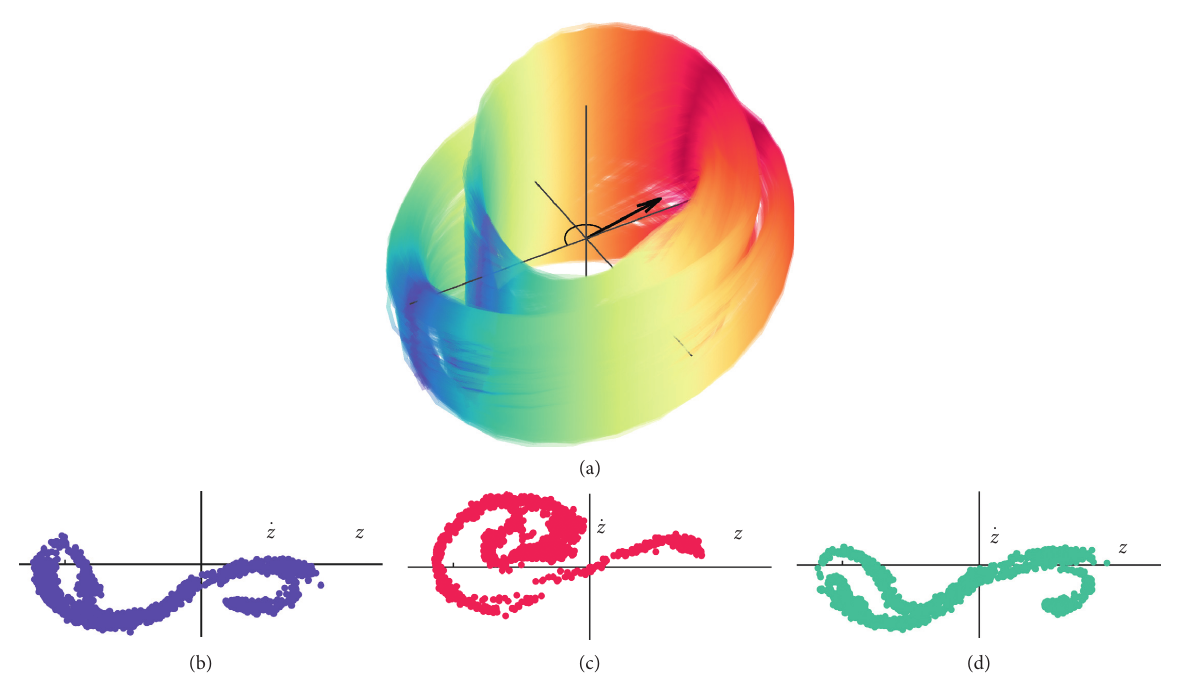
Figure 15: Experimental Poincar´e sections, b � 5mm: (a) polar representation of the attractor surface; (b) Poincar´e section, ϕ � 0 ° ; (c) 0 Poincar´e section, ϕ � 170 ° ; (d) Poincar´e section, ϕ � 320 ° .